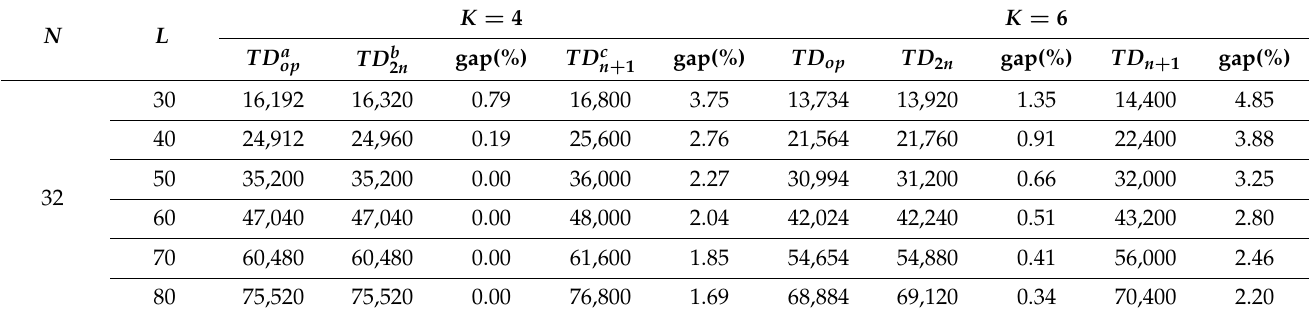
Table 6. Evaluation of two rules with an even number of